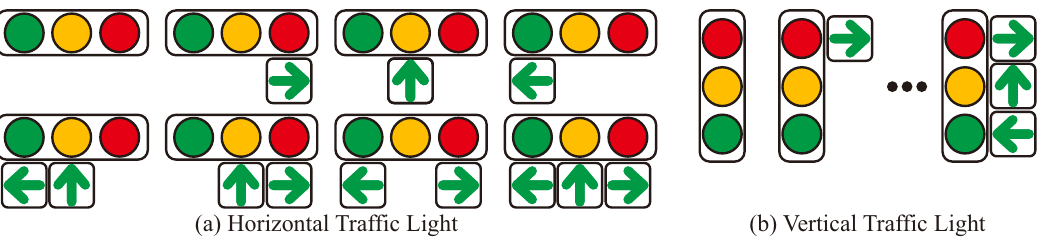
Figure 1. Typical traffic light image at different brightness and region of interest (ROI) image.